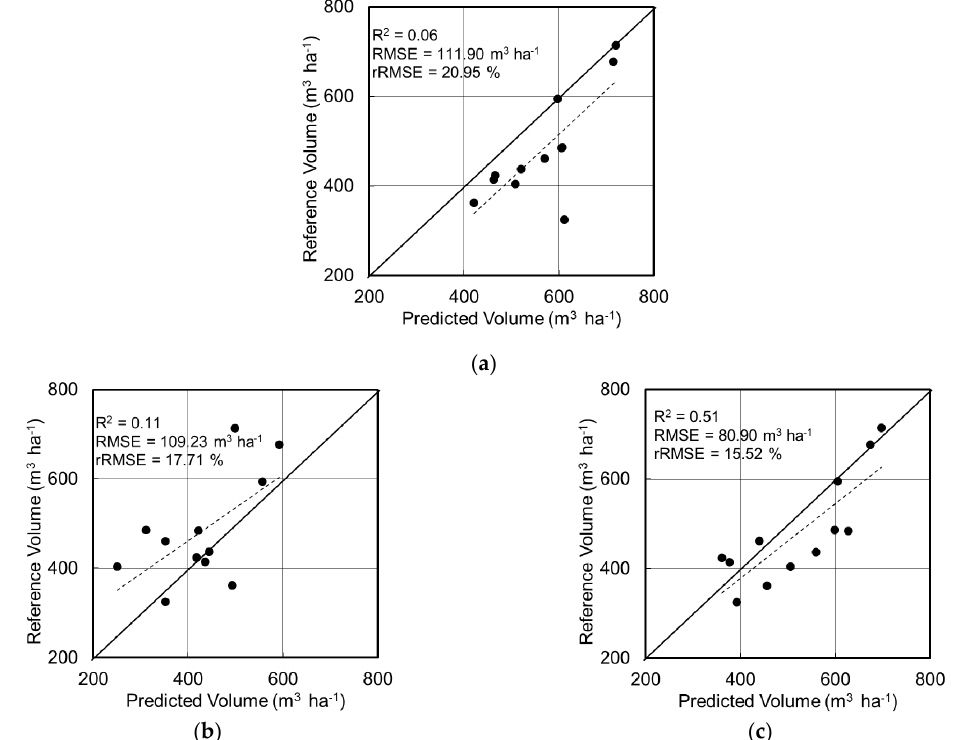
Figure 10. Results from the RFR analysis. Comparison of the reference and predicted stem volumes for additional models using, ( a ) minimum UAS variables (CHM avg , CA avg , FCC) ( b ) SAR variables, and ( c ) UAS+SAR variables. The solid black line indicates the 1:1 line. The dotted line is the linear trend line between the predicted and reference volume just for the visual reference, and it does not represent the R 2 shown.